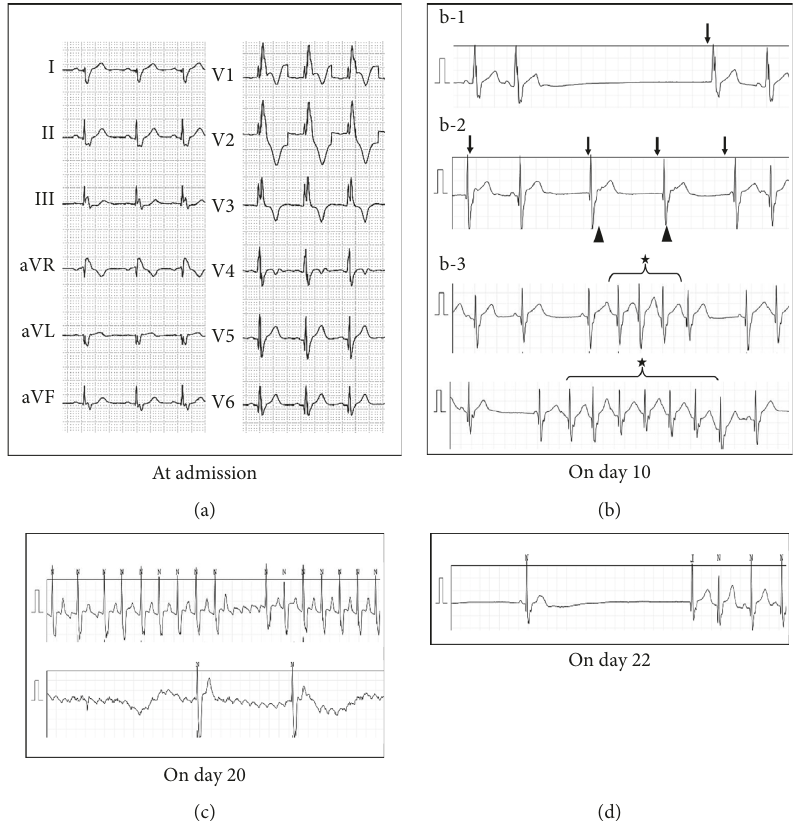
Figure 1: Electrocardiograms (a). Sinus arrest was detected (b-1), junctional rhythms ( ↓ ) were pointed with retrograde P waves ( ▲ ), and short bursts of atrial tachycardia were detected ( ★ ). Atrial flutter occured with a resultant 2 :1 to 4:1 atrioventricular conduction block (c). Sinus arrest occured (maximum, 5.7s)